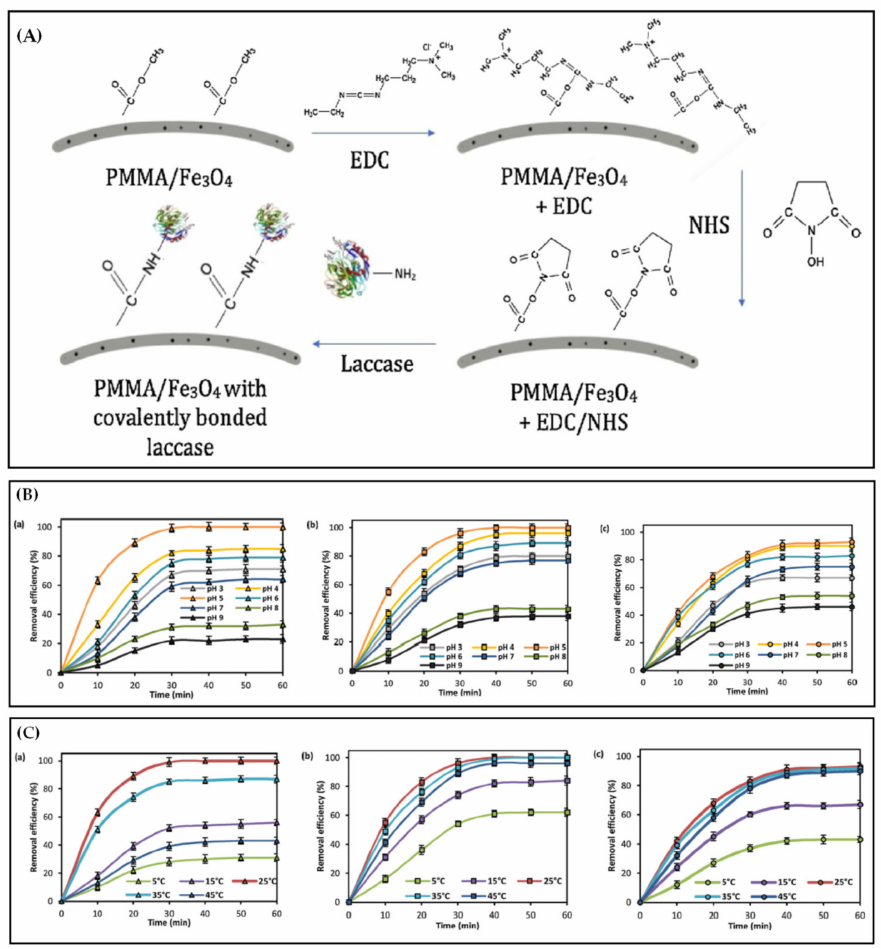
Figure 13. ( A ) Schematic of functionalization of PMMA/Fe 3 O 4 nanofibers by the EDC/NHS method and covalent immobilization of laccase. ( B ) Effect of pH value on tetracycline removal by free enzyme ( a ), covalently bound laccase ( b ) and encapsulated laccase ( c ). ( C ) Effect of temperature on tetracycline removal by the free enzyme ( a ), covalent bound laccase ( b ) and encapsulated laccase ( c )